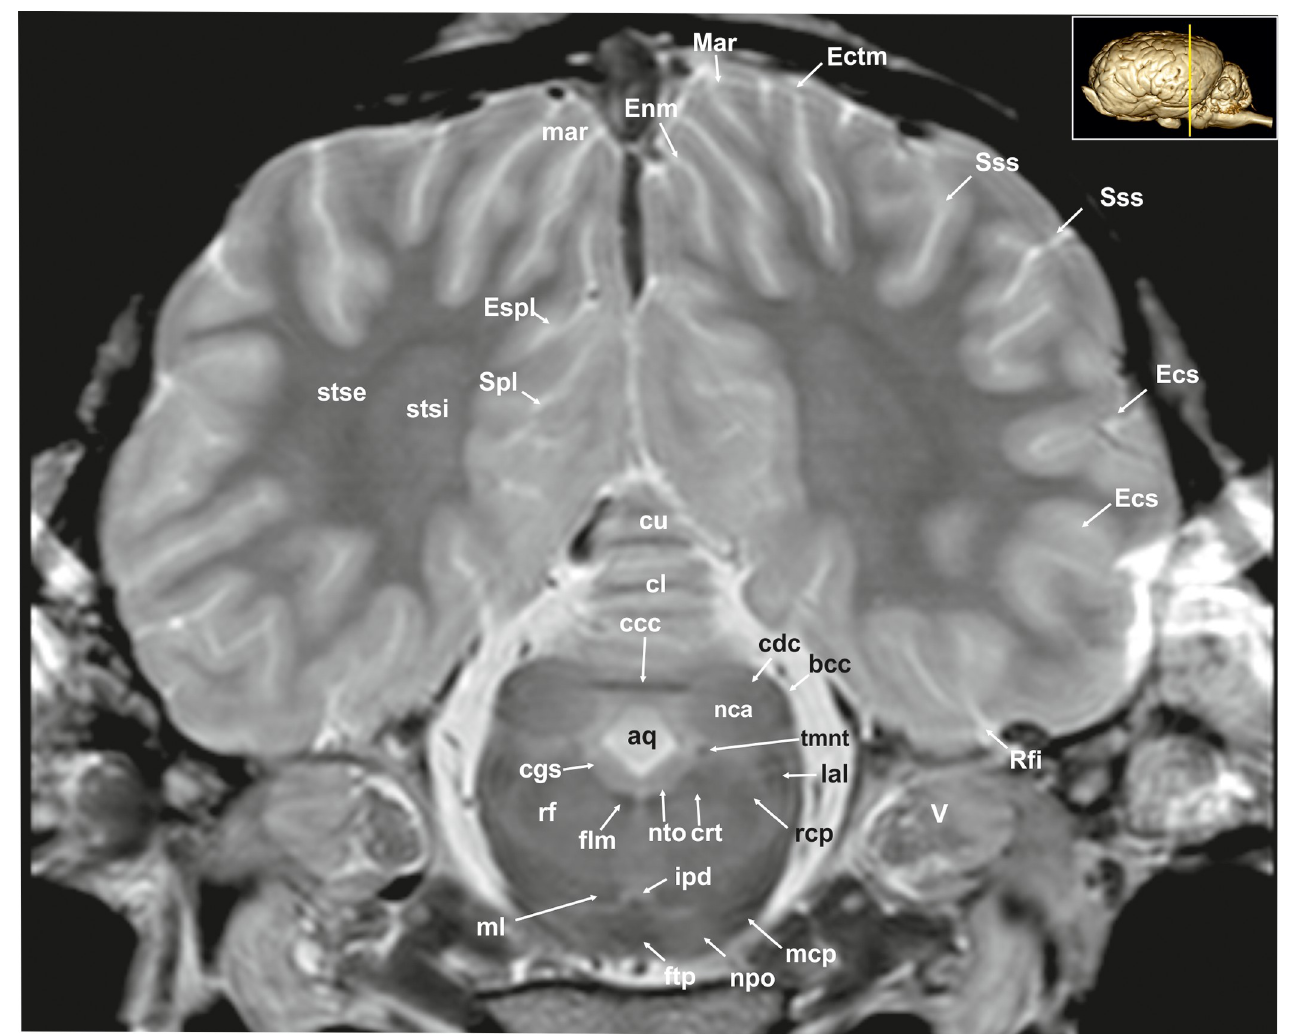
Fig 11. Transverse magnetic resonance image of the equine brain on the level of the caudal colliculi. aq: mesencephalic aqueduct, bcc: brachium of the caudal colliculus, ccc: commissure of the caudal colliculus, cdc: caudal colliculus, cgs: central grey substance, cl: central lobule, crt: rubro-cerebello-thalamic tract, cu: culmen, Ecs: ectosylvian sulcus, Ectm: ectomarginal sulcus, Enm: endomarginal sulcus, Espl: ectosplenial sulcus, flm: medial longitudinal fasciculus, ftp: transverse fibres of the pons, ipd: interpeduncular nucleus, lal: lateral lemniscus, mar: marginal gyrus, mcp: medial cerebellar peduncle, mgb: medial geniculate body, ml: medial lemniscus, nca: nucleus of the caudal colliculus, npo: nuclei of the pons, nll: Nucleus of the lateral lemniscus, nto: nucleus of trochlear nerve, rcp: rostral cerebellar peduncle, rf: reticular formation, Rfi: rhinal fissure, Spl: splenial sulcus, Sss: suprasylvian sulcus, stse: stratum sagittale externum, stsi: stratum sagittale internum, tmnt: mesencephalic tract of the trigeminal nerve, V: trigeminal nerve. ecs) referred to as the rostral and caudal oblique gyrus (Gyrus obliquus caudalis; Figs 1, 7 and 9: obl) separated by the corresponding sulcus (Figs 1A, 1C and 24: Obl) [23]. The suprasylvian sulcus (Sulcus suprasylvius; Figs 1A, 1C, 2–13, 23–25, 32 and 33; S1–S6 Figs: Sss) is positioned dorsally to the sylvian sulcus and the ectosylvian sulci. Further caudally and dorsally the mar- ginal sulcus (Figs 1C, 5, 7, 8–10, 12–13 and 23–25; S6 Fig: Mar) can be found, flanked medially by the endomarginal sulcus (Figs 1C, 1E, 8, 10, 11, 12, 23, 24, 25, 26 and 28: Enm) and laterally by the ectomarginal sulcus (Figs 1A, 1C, 8–13, 23–25 and 33: Ectm). The ectomarginal sulcus is positioned dorsocaudally to the suprasylvian sulcus and ventrolaterally to the marginal sul- cus. The endomarginal sulcus is positioned mediodorsal to the marginal sulcus.